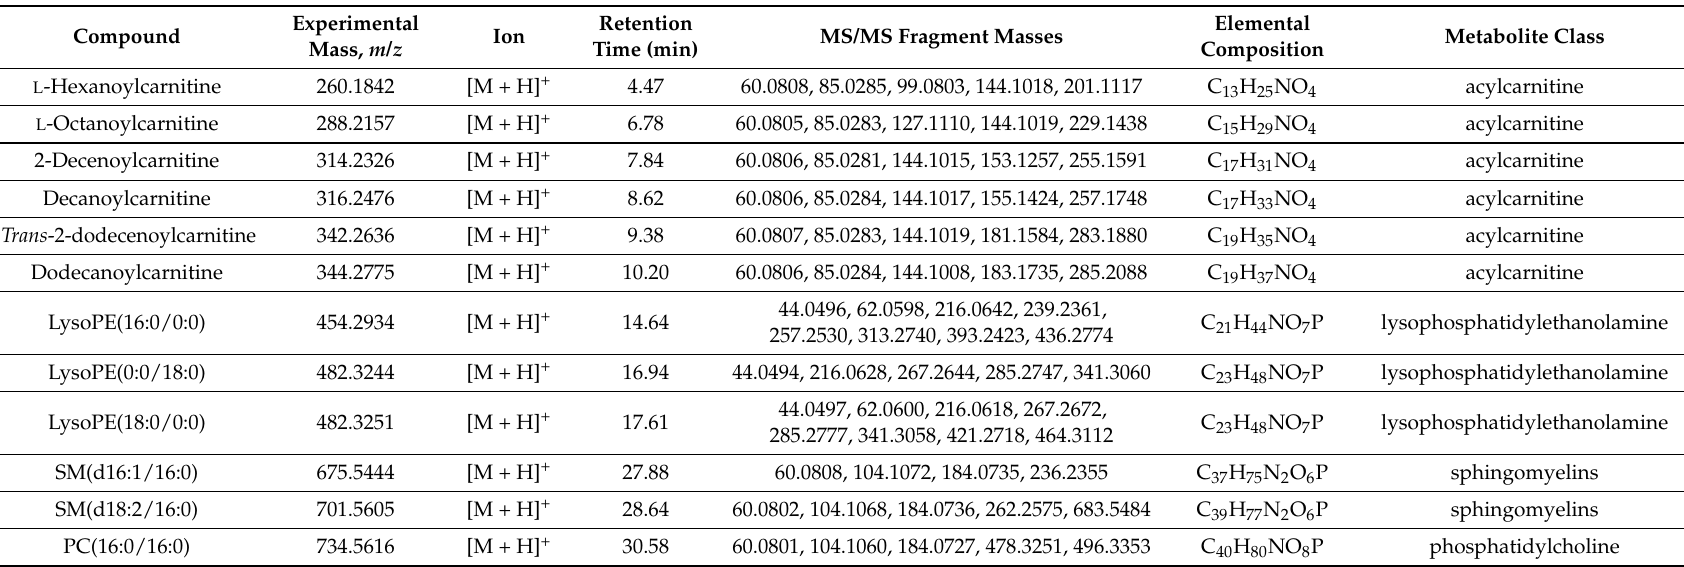
Table 1. Plasma metabolites with higher levels in melioidosis patients compared to bacterimia patients and